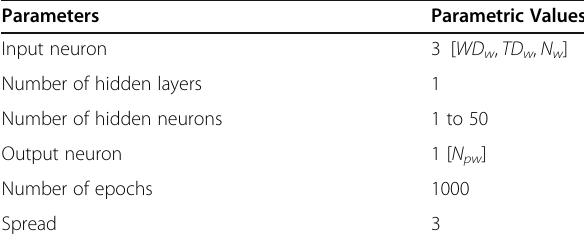
Table 4 Parameters for RRBFNN Parameters Parametric Values